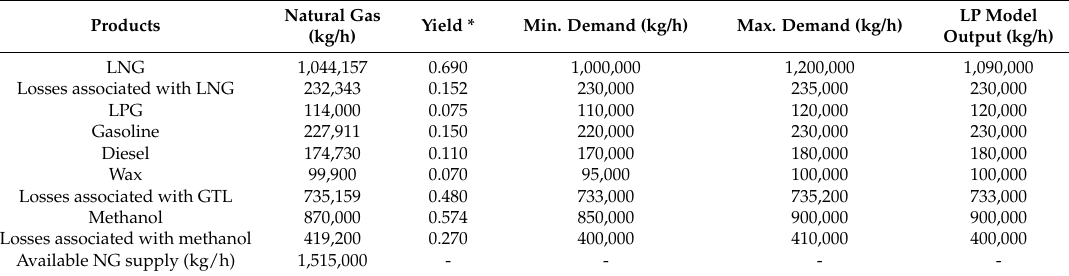
Table 3. Yields and products flowrates obtained from simulation and LP